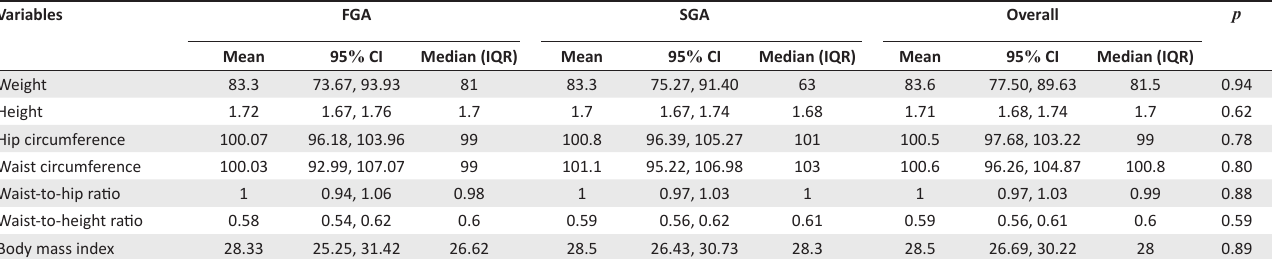
TABLE 3: Body measures of male inpatients with severe mental illness, on first-generation antipsychotics and second-generation antipsychotics, at Weskoppies Psychiatric Hospital, South Africa.